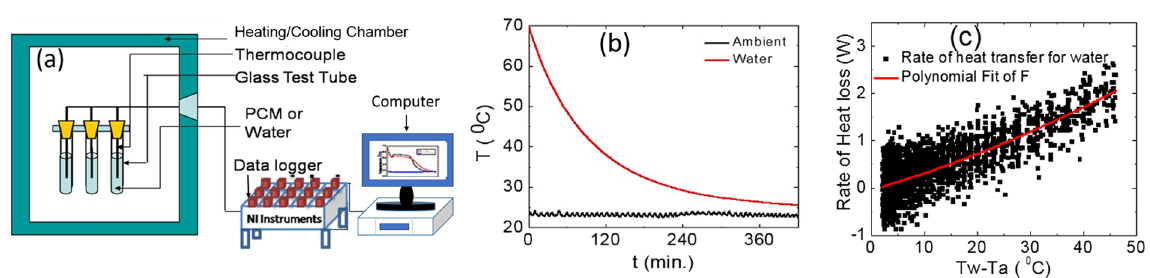
Figure 4. ( a ) Schematic of semi-automated T-history measuring test setup, ( b ) T-history curve for DI water, ( c ) calculated heat loss from water test tube vs. temperature difference between ambient and DI water